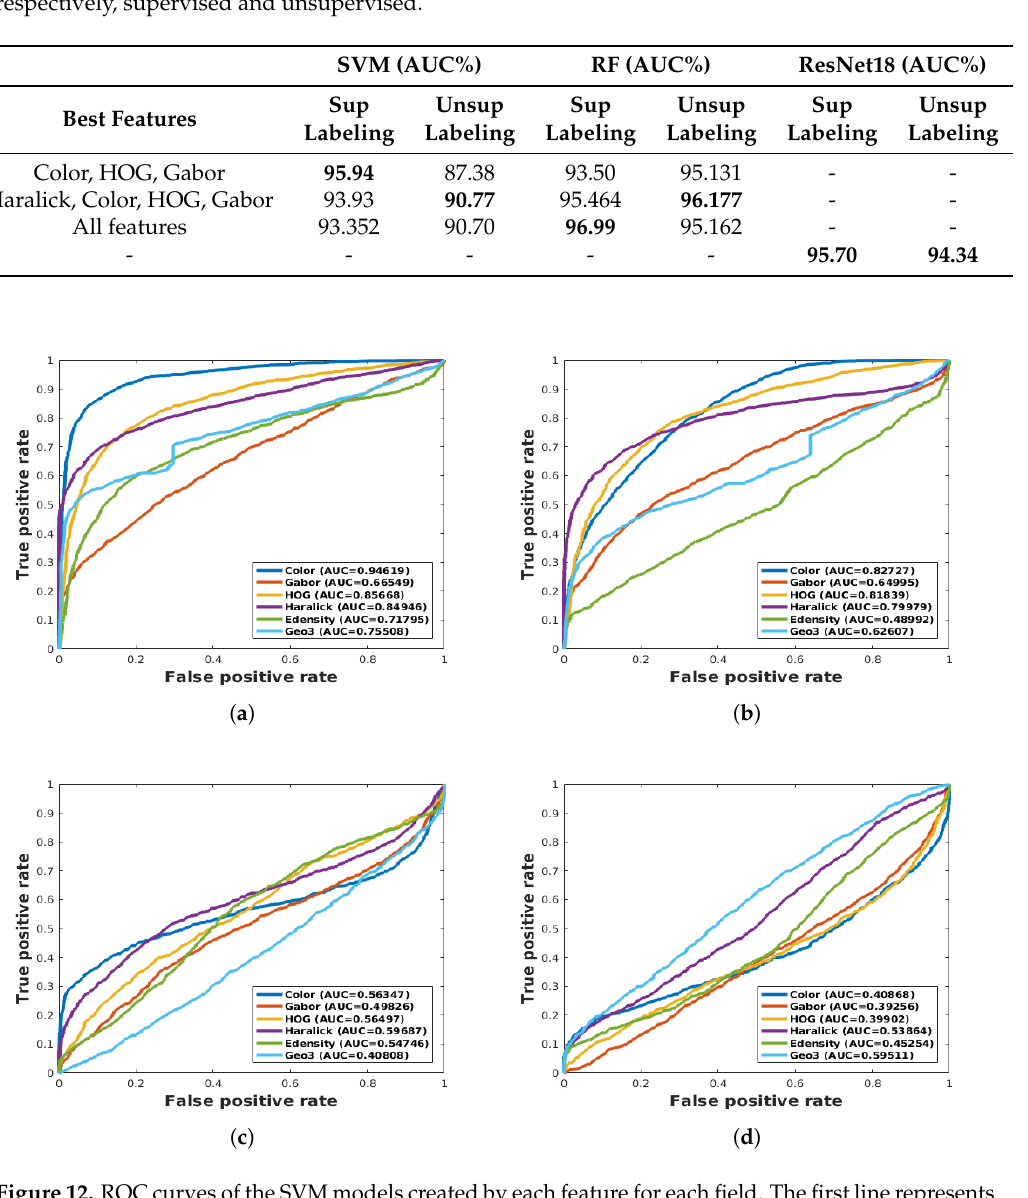
Table 4. Results of test data collected in the spinach field with ResNet18, SVM, and random forest. For the SVM and RF, only the results of the best selected features are presented. Sup and Unsup mean, respectively, supervised and unsupervised.